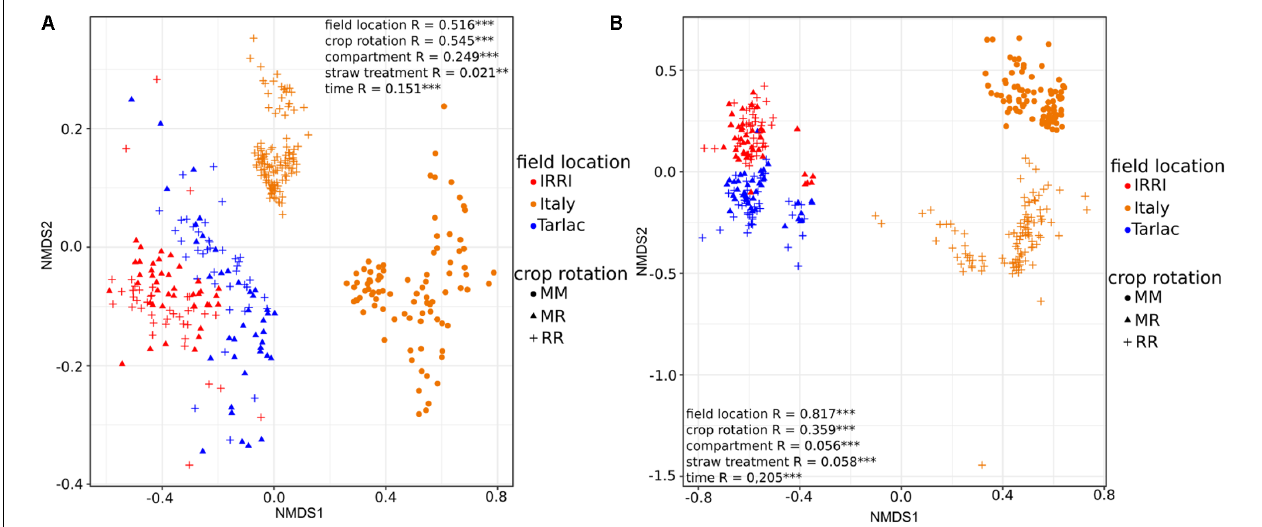
FIGURE 1 | Ordination plots showing the influence of field location and crop rotation on bacterial (A) and fungal (B) community composition. Non-metric multidimensional scaling (NMDS) plots based on Bray–Curtis dissimilarities were calculated from relative OTU abundances. Results of analysis of similarity (ANOSIM) are shown with ∗ P < 0.05, ∗∗ P < 0.01, ∗∗∗ P < 0.001 for all grouping factors.